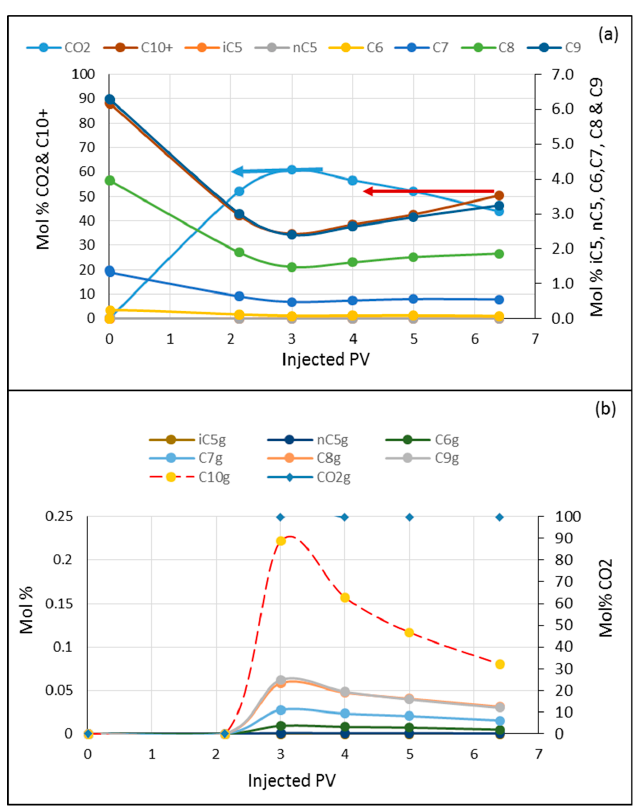
Figure 7. Dynamic composition changes as a function of the injected pore volume of CO 2 into crude oil ( a ) in liquid phase and ( b ) in vapor phase.